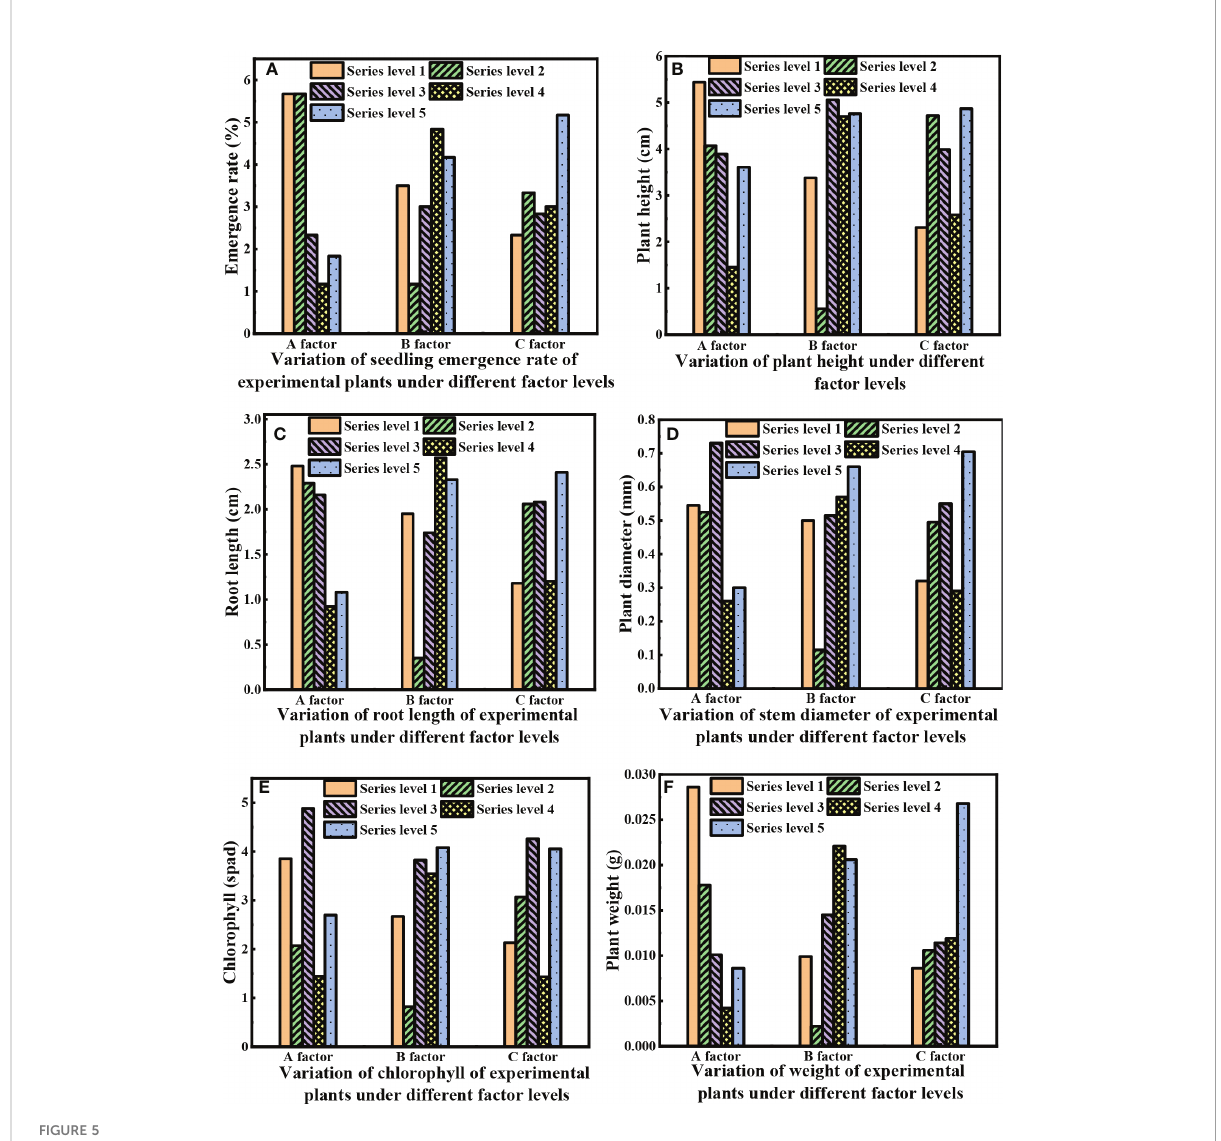
FIGURE 5 Variation of agronomic characters of test plants with factor